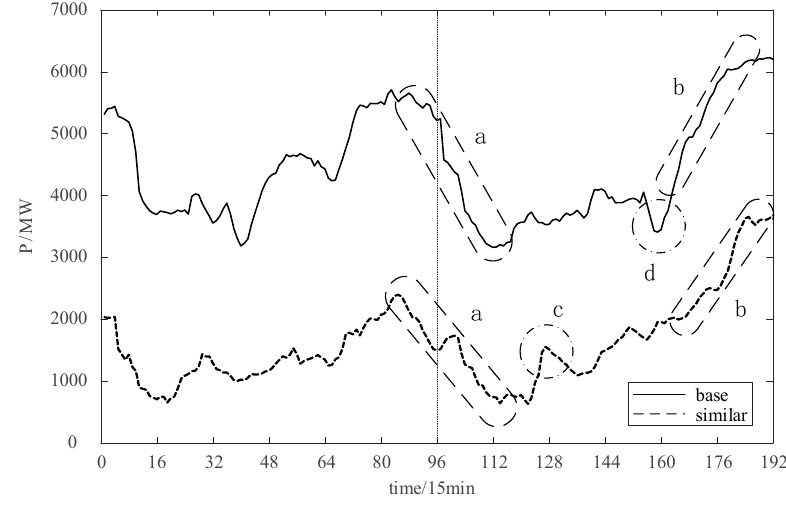
Figure 2. Trend comparison of similar days.